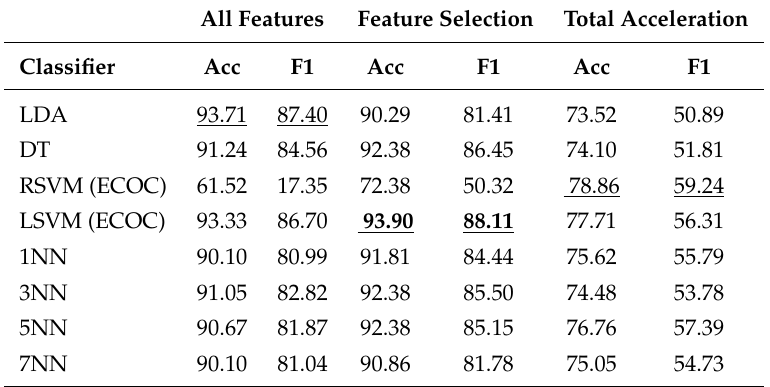
Table 3. Classification accuracy (%) and F1-score (%) for the seven-class problem (ADL and Fall).